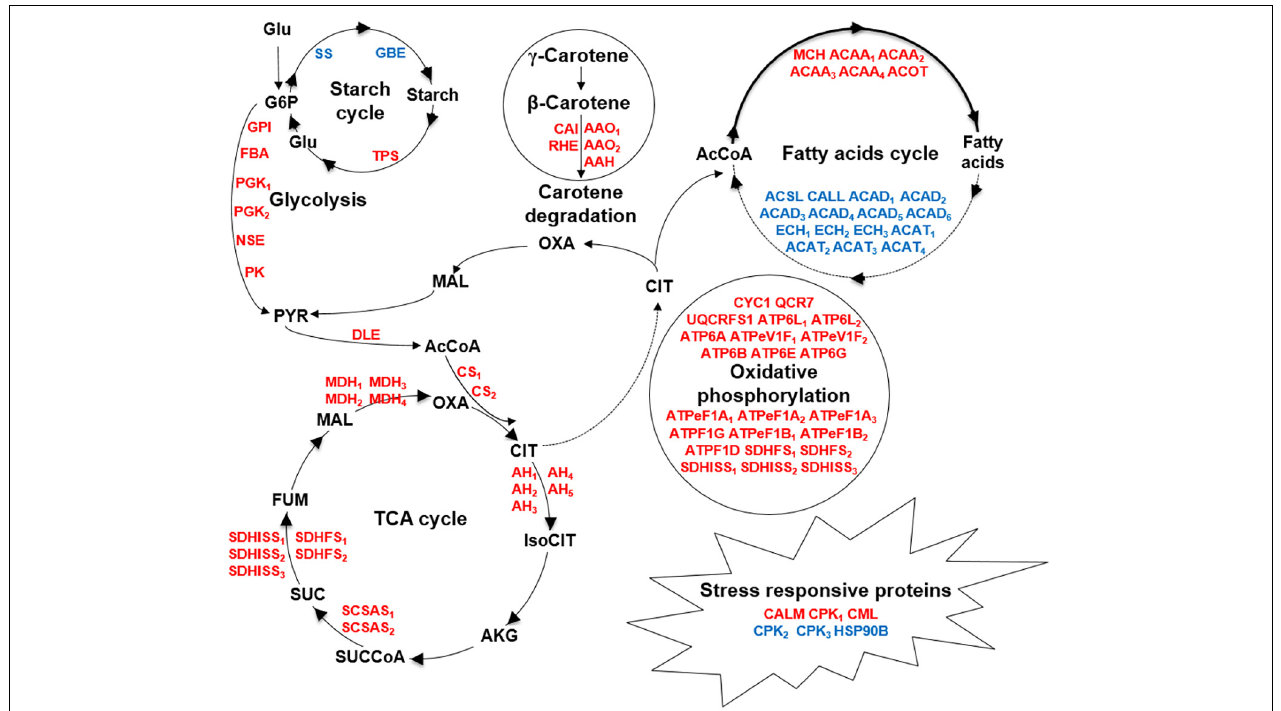
FIGURE 6 | Comparative metabolic responses to fermentation supernatant stress between FS280 and WT. Upregulated and downregulated proteins are indicated by red and blue, respectively. Glu, glucose; G6P, glucose-6-phosphate; PYR, pyruvate; AcCoA, acetyl-CoA; CIT, citrate; IsoCIT, isocitrate; AKG, α -ketoglutarate; SUCCoA, succinyl-CoA; SUC, succinate; FUM, fumarate; MAL, malate; OXA, oxaloacetate; GPI, glucose-6-phosphate isomerase; FBA, fructose-bisphosphate aldolase; PGK, phosphoglycerate kinase; NSE, enolase; PK, pyruvate kinase; DLE, dihydrolipoamide dehydrogenase; CS, citrate synthase; AH, aconitate hydratase; SCSAS, succinyl-CoA synthetase alpha subunit; SDHFS, succinate dehydrogenase (ubiquinone) flavoprotein subunit; SDHISS, succinate dehydrogenase (ubiquinone) iron-sulfur subunit; MDH, malate dehydrogenase; ACAA, acetyl-CoA acyltransferase 1; ACOT, acyl-coenzyme A thioesterase 1/2/4; MCH, medium-chain acyl-[acyl-carrier-protein] hydrolase; ECH, enoyl-CoA hydratase; ACAD, acyl-CoA dehydrogenase; ACSL, long-chain acyl-CoA synthetase; ACAT, acetyl-CoA C-acetyltransferase; CALL, long-chain-fatty-acid–CoA ligase ACSBG; SS, starch synthase; GBE, 1,4-alpha-glucan branching enzyme; TPS, trehalose 6-phosphate synthase/phosphatase; CAI, beta-carotene isomerase; RHE, beta-ring hydroxylase; AAO, abscisic-aldehyde oxidase; AAH, (+)-abscisic acid 8’-hydroxylase, CALM, calmodulin; CPK, calcium-dependent protein kinase; CML, calcium-binding protein CML; HSP90B, heat shock protein 90 kDa beta; CYC1, ubiquinol-cytochrome c reductase cytochrome c1 subunit; QCR7, ubiquinol-cytochrome c reductase subunit 7; ATP6L, V-type H+-transporting ATPase 16 kDa proteolipid subunit; ATP6A, V-type H+-transporting ATPase subunit A; ATPeV1F, V-type H+-transporting ATPase subunit F; ATP6B, V-type H+-transporting ATPase subunit B; ATP6E, V-type H+-transporting ATPase subunit E; ATP6G, V-type H+-transporting ATPase subunit G; ATPeF1A, F-type H+-transporting ATPase subunit alpha; ATPF1G, F-type H+-transporting ATPase subunit gamma; ATPeF1B, F-type H+-transporting ATPase subunit beta; ATPF1D, F-type H+-transporting ATPase subunit